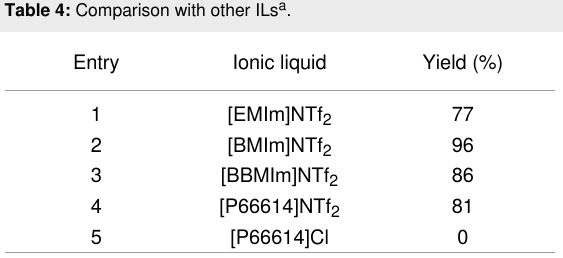
Table 4: Comparison with other ILs a